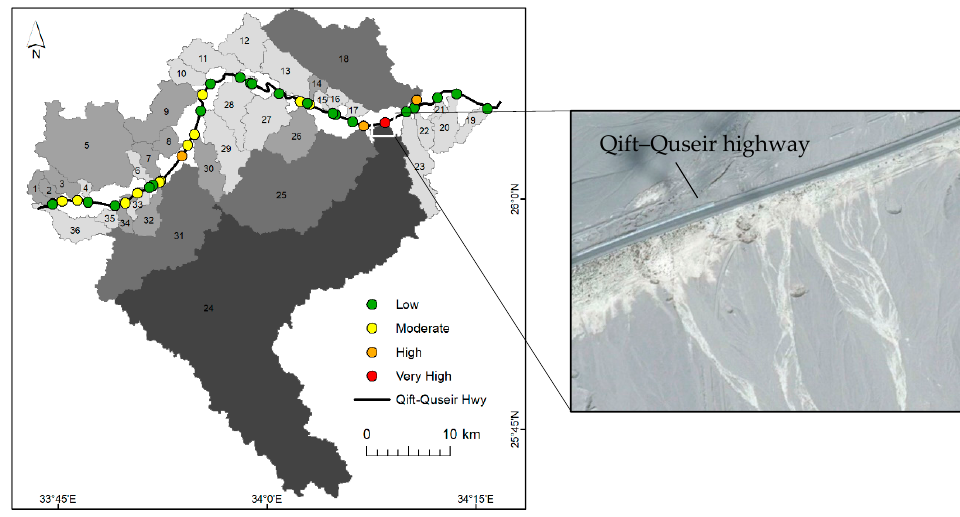
Figure 8. Illustrates the 36 sub-basins that drain toward the Qift–Quseir Highway. The figure highlights the hazard levels of these sub-basins in regard to their physiographic characteristics, drainage network, and soil properties. Right: A close-up look to the site categorized as very high flood risk. It shows traces of surface runoff flowing toward the Qift–Quseir Highway and causing road erosion at this locality (Source: Google Earth